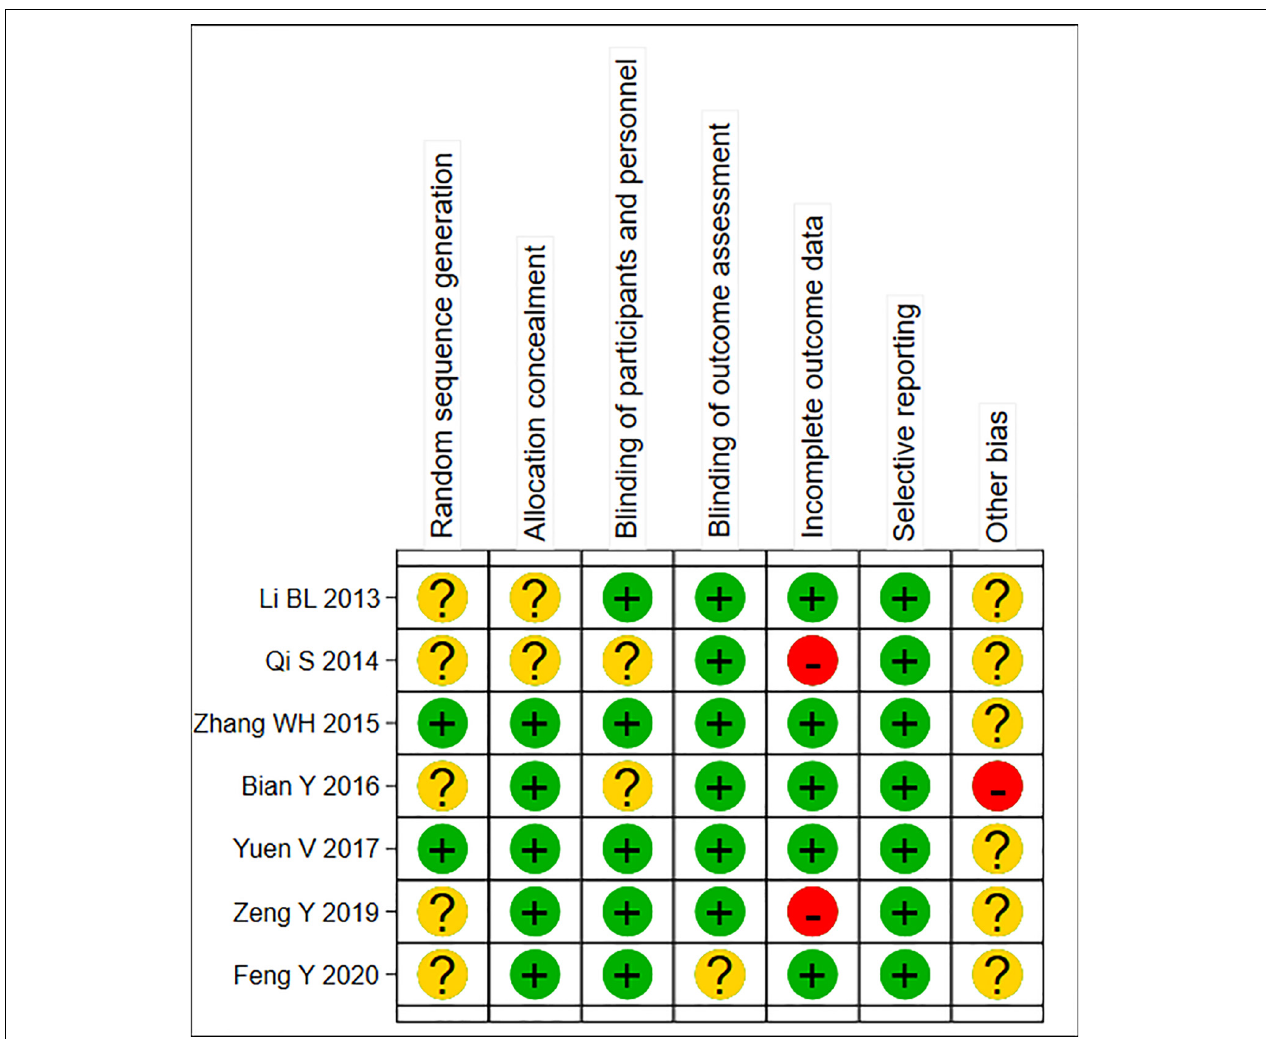
FIGURE 2 | Summary risk assessment of literature bias. “Yes” indicates “low risk of bias”; “Unclear” indicates “moderate risk of bias”; “No” indicates “high risk of bias”.